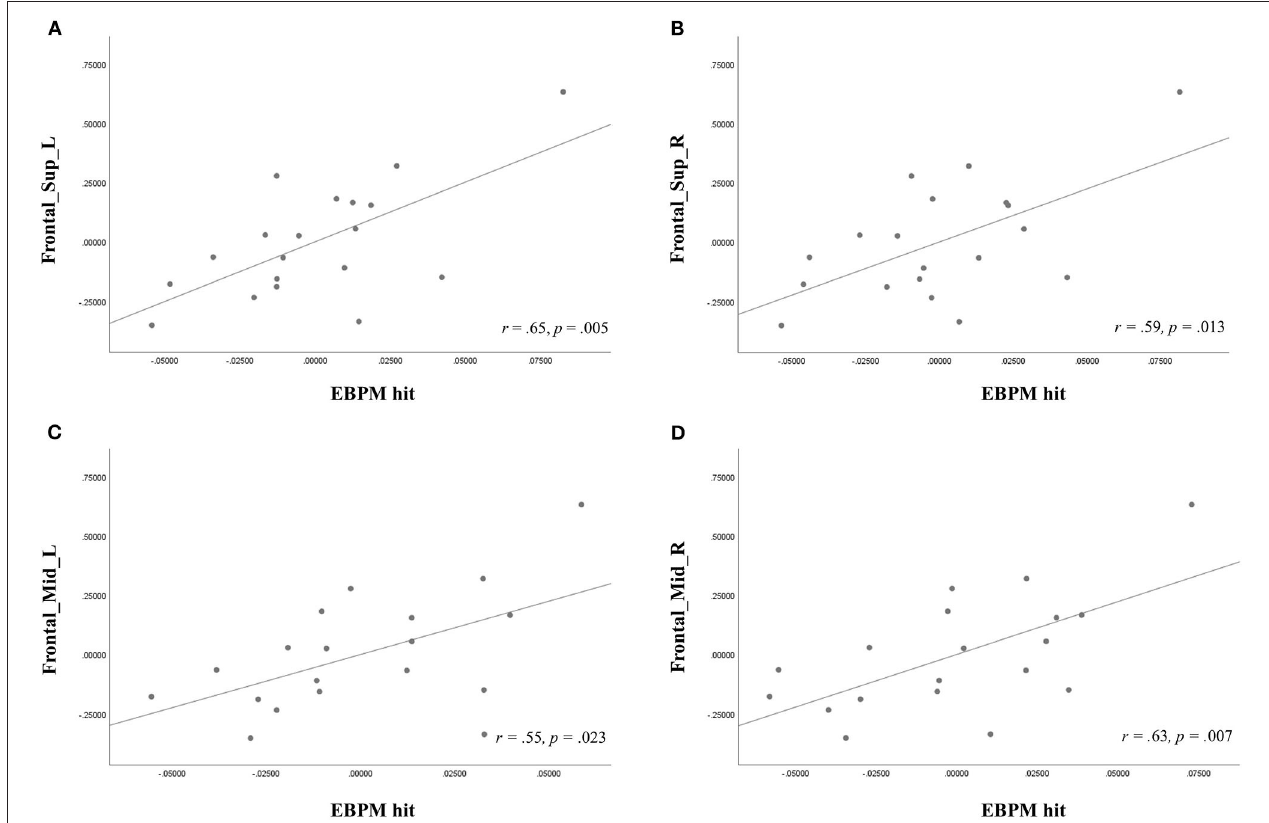
FIGURE 2 | Partial correlation analysis, showing the relationship of event-based prospective memory (EBPM) hit with regional homogeneity (ReHo) in the (A) left superior frontal gyri, dorsolateral portion (Frontal_Sup_L), (B) right superior frontal gyri, dorsolateral portion (Frontal_Sup_R), (C) left middle frontal gyrus (Frontal_Mid_L), and (D) right middle frontal gyrus (Frontal_Mid_R) after controlling for age and antihypertensives use in the subcortical ischemic vascular disease